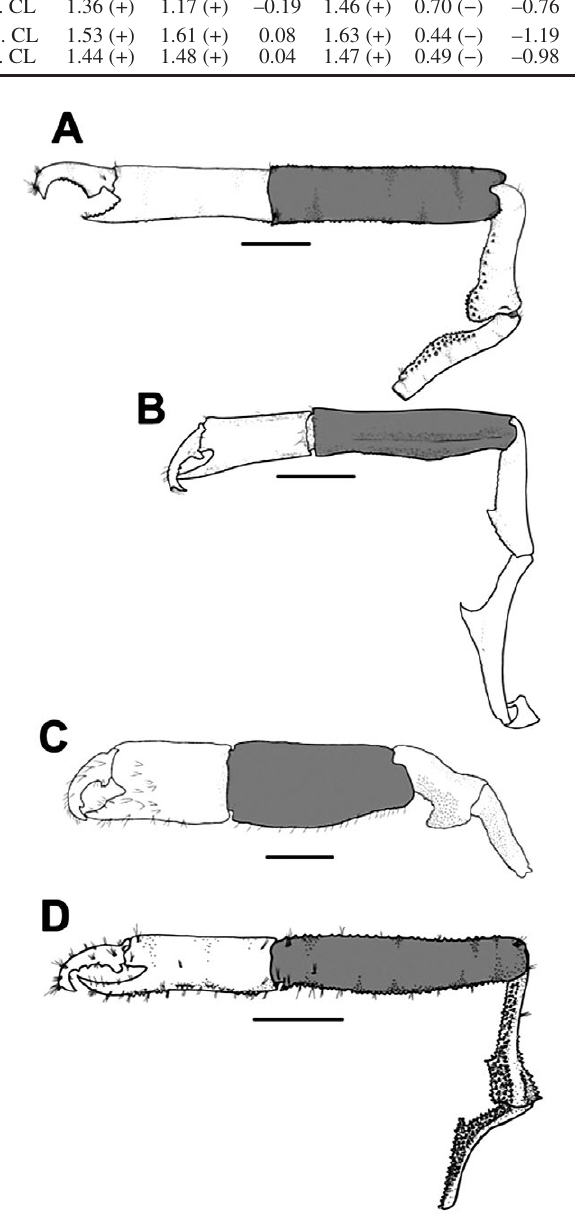
Fig. 6. – Male larger cheliped (carpus in grey) in four American species of Callichirus : A, C. garthi ; B, C. islagrande ; C, C. major ; and D, C. seilacheri . (A, D, redrawn from Hernáez et al. 2015; B, Hernáez unpublished data; C, present